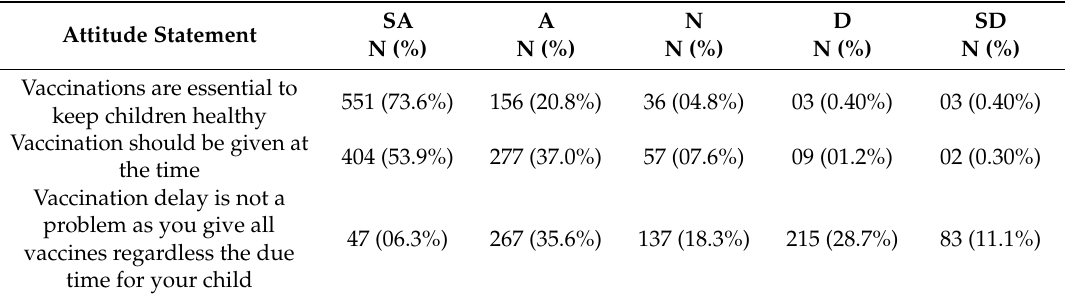
Table 2. Assessment of parents’ attitudes concerning childhood vaccination timeliness during Table2. Assessmentofparents’attitudesconcerningchildhoodvaccinationtimelinessduringCOVID-19 COVID-19 (n = ( n = 749).